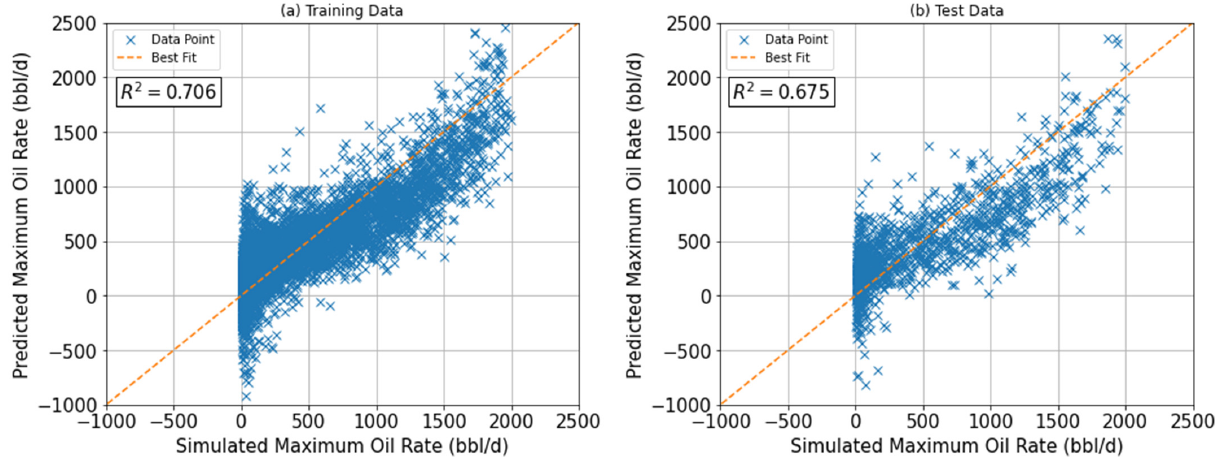
Figure 7. Predicted and simulated plot of ( a ) training data and ( b ) testing data for maximum oil rate—polynomial regression model. Figure 8. Predicted and simulated plot of ( a ) training data and ( b ) testing data for maximum oil rate—neural network model.